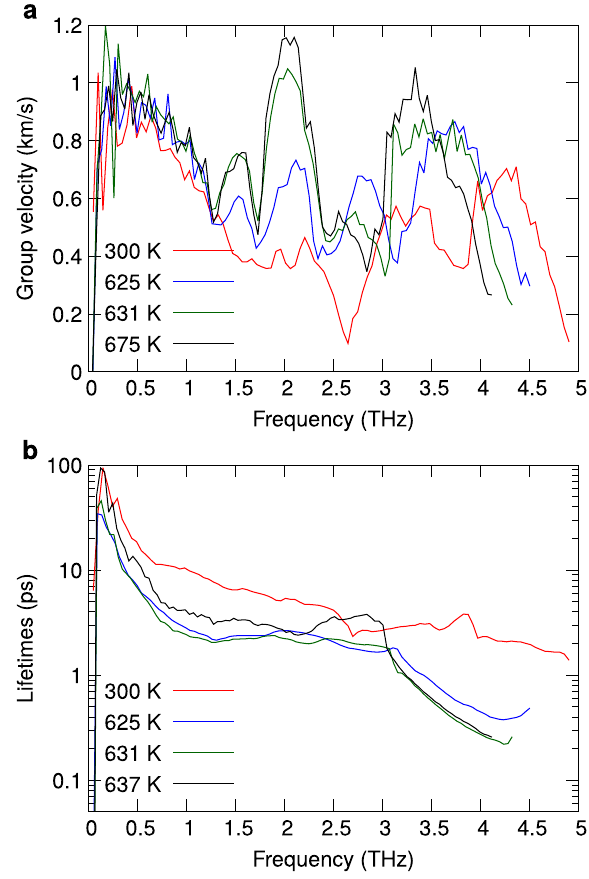
Fig. 5 Frequency dependence of phonon transport properties. a Average phonon group velocities and b average phonon lifetimes of GeTe vs. phonon frequency for different temperatures. Averaging is carried out by convolving the calculated values of these quantities with a Gaussian (see Eq.